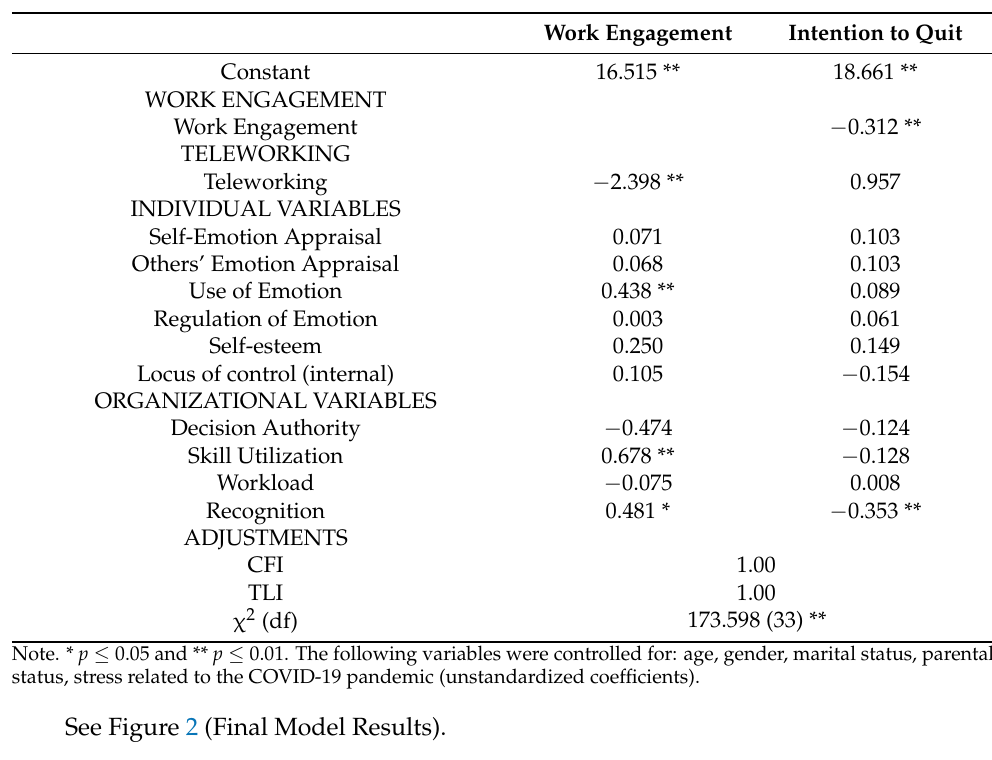
Table 3. Indirect Effects of Teleworking, Individual, and Organizational Variables on Intention to Quit.